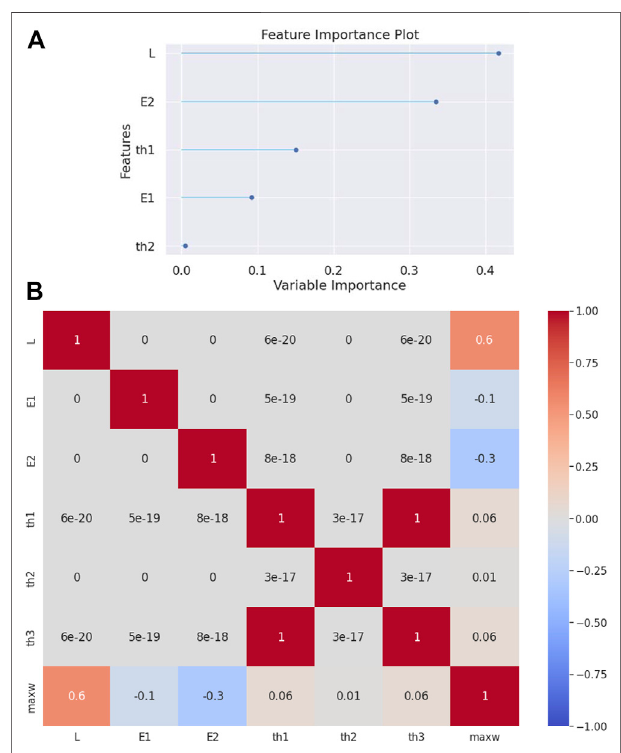
FIGURE 5 | (A) Feature importance plot and (B) correlation matrix heatmap for the clamped-free beam.